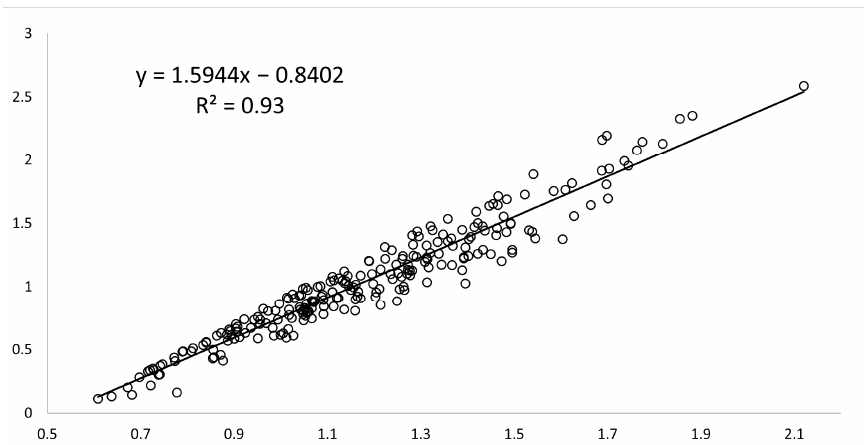
Figure 4. Logarithmic plot for image analysis of whey protein hydrolysate.